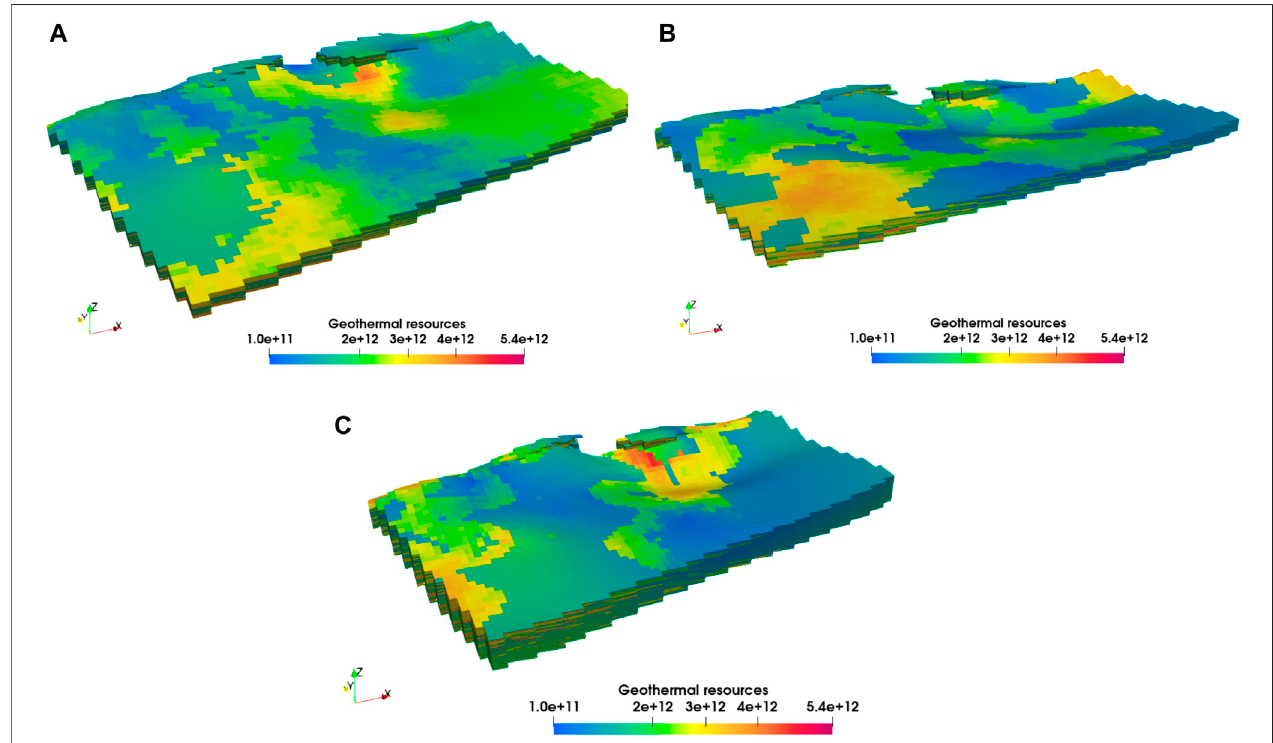
FIGURE 10 | 3D model showing the geothermal resource (J) distribution: (A) member Ng1, (B) member Ng2, and (C) member Ng3.